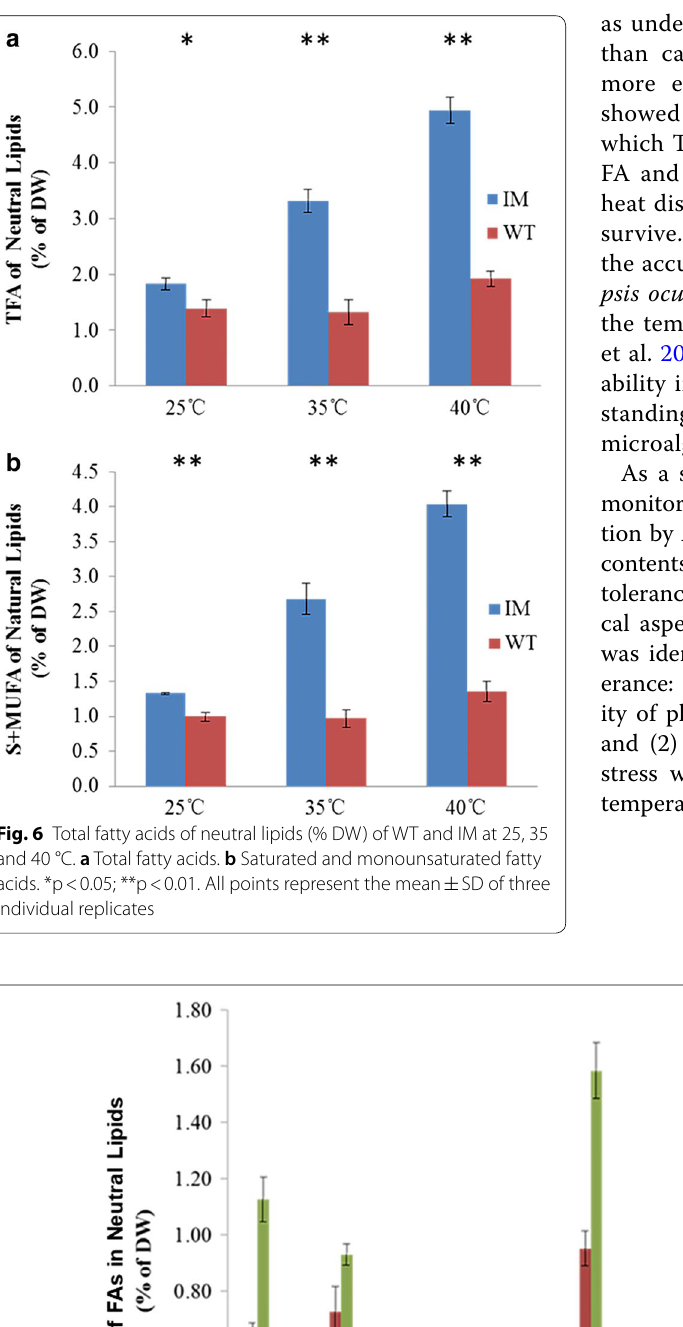
Fig. 7 Fatty acid content (% DW) of neutral lipids of WT and IM at 25, 35 and 40 °C. All points represent the mean